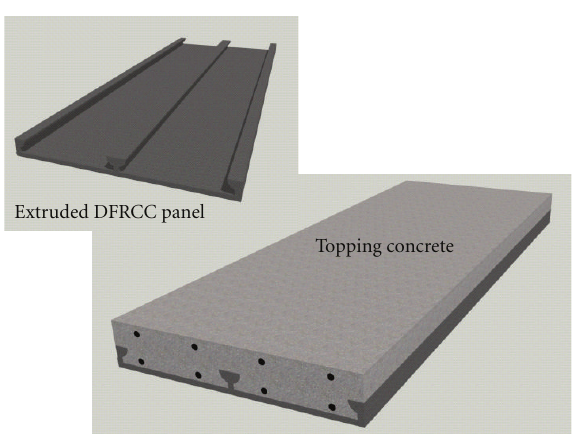
Figure 6: Cross-section of RC composite slab system with extruded DFRCC